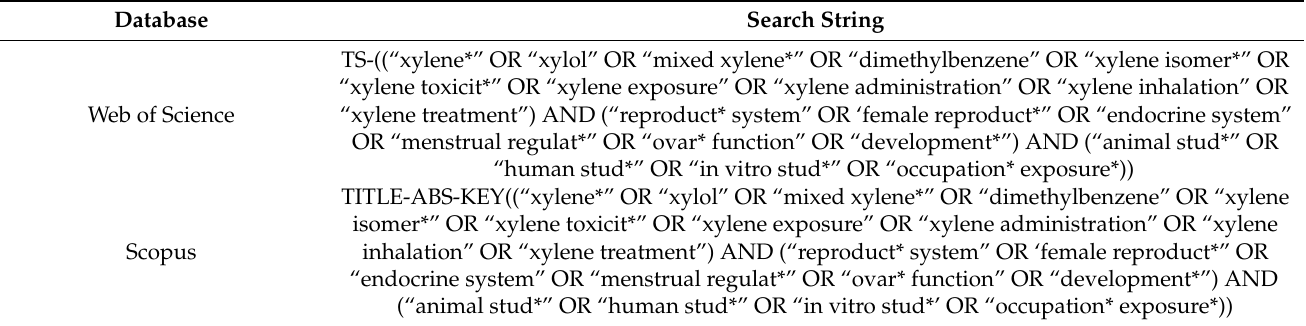
Table 1. The search string. An asterisk (*) is used for multiple character searching.